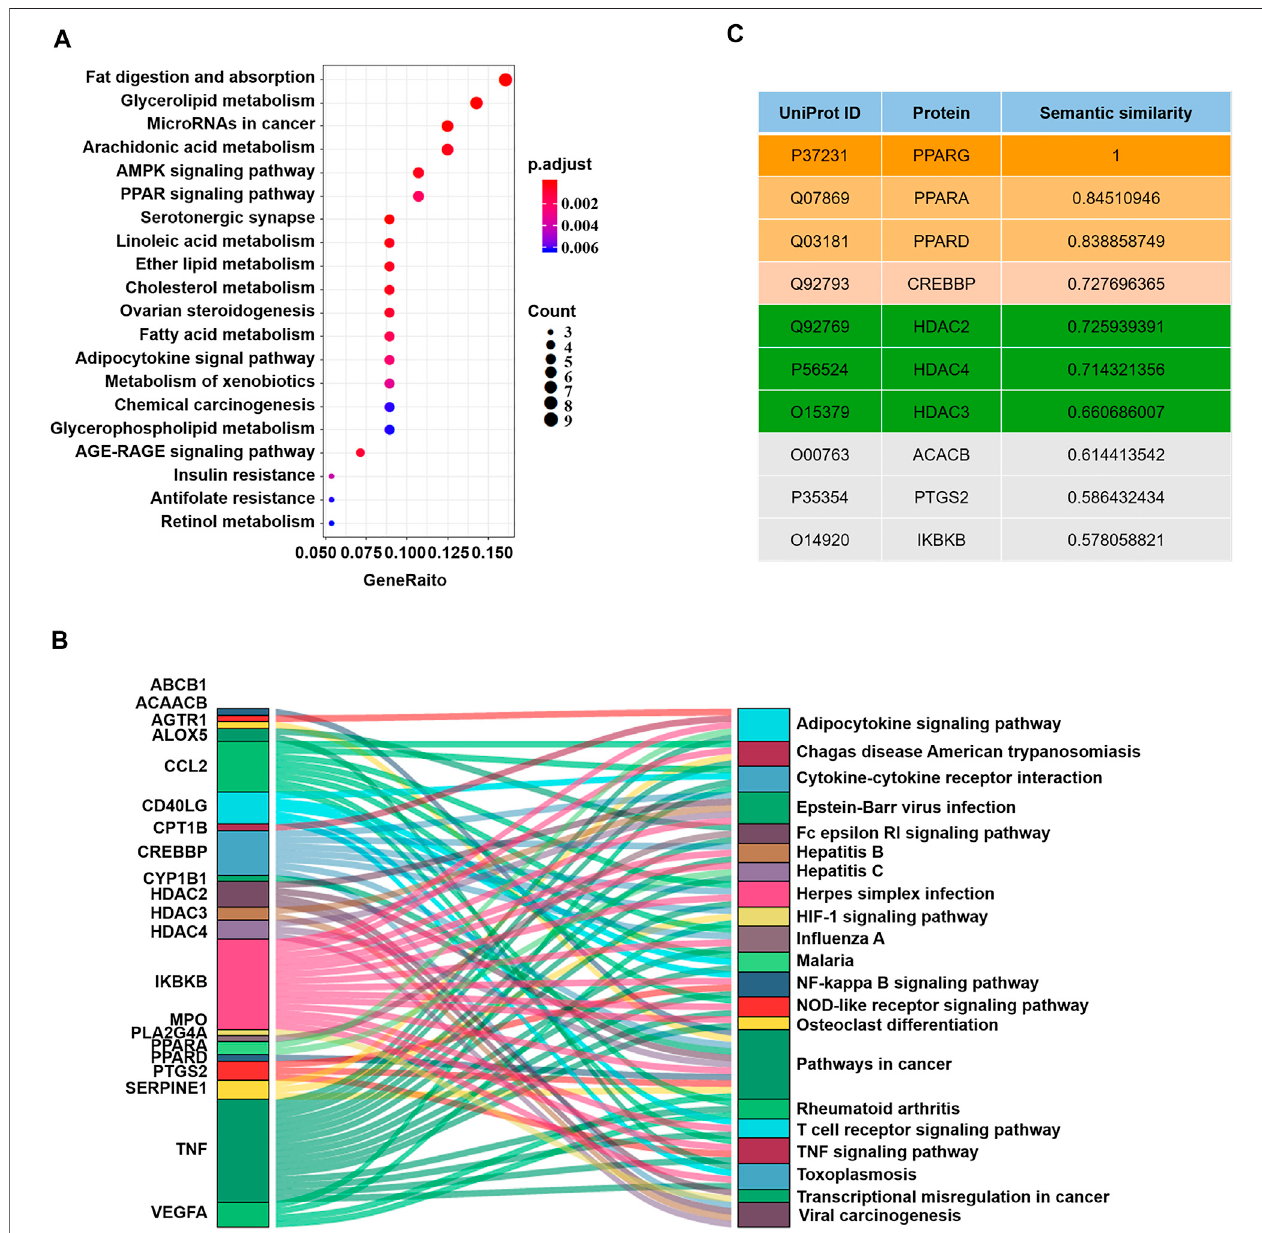
FIGURE 2 | Measurement of the possibility of synergy. (A) KEGG pathway enrichment analysis on druggable target proteins. (B) Sankey plots of the pathways enriched for the druggable genes. (C) The top 10 candidate target proteins with semantic similarity scores and their UniProt IDs.